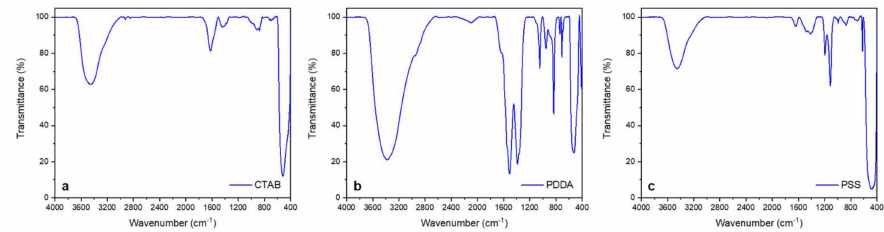
Figure 4. FTIR spectra of ( a ) CTAB-, ( b ) PDDA-, and ( c ) PSS-stabilized ZnONPs.